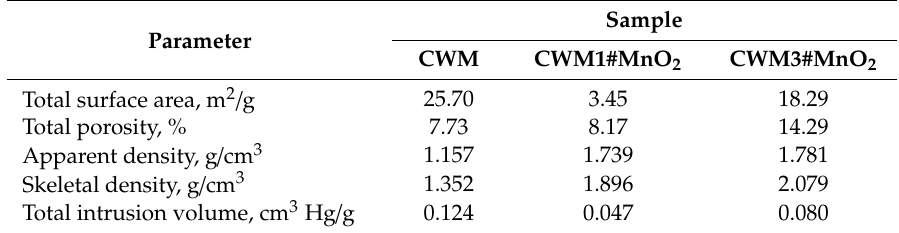
Table 4. Porous characteristics of polymeric raw material and hybrid materials by mercury intrusion